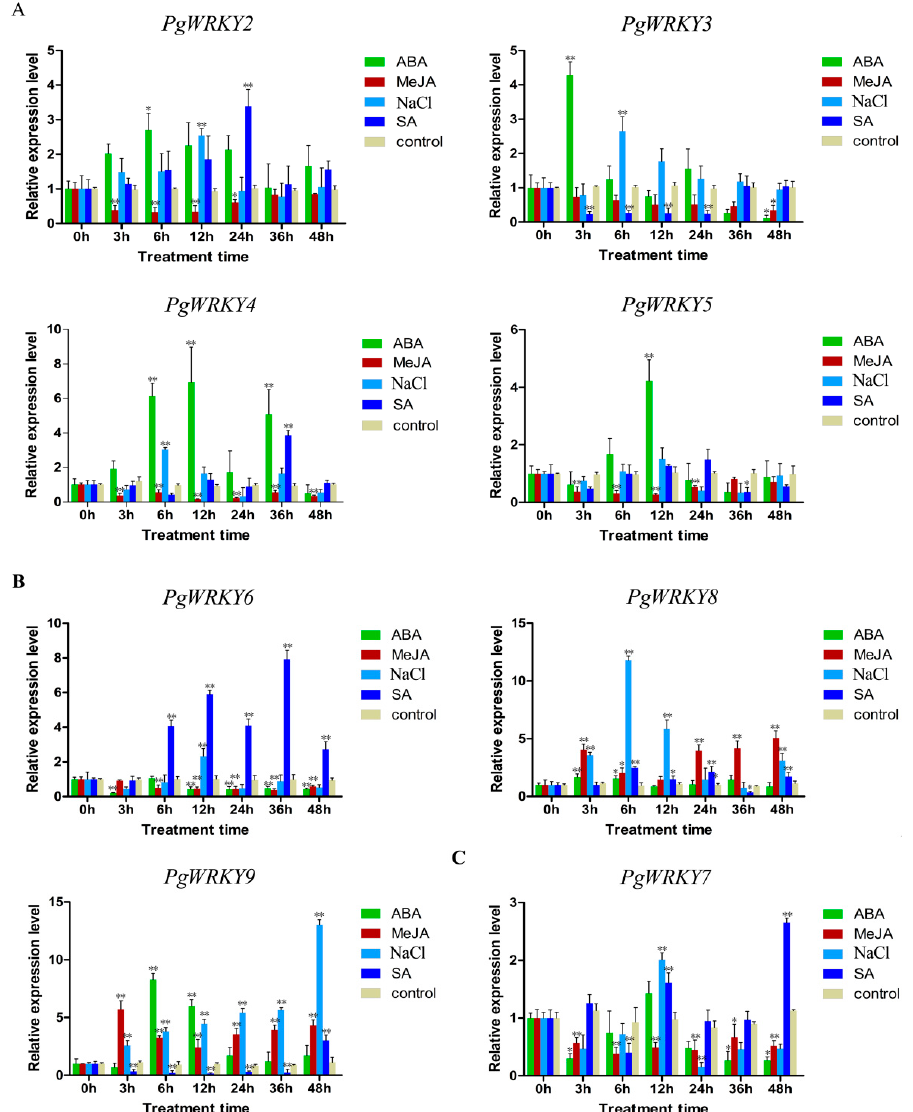
Figure 5. Expression profiles of the eight analyzed PgWRKYs ( PgWRKY2-9 ) in P. ginseng hairy roots treated with 200 µM MeJA, 200 µM SA, 20 µM ABA, and 50 mM NaCl. ( A ) Subgroup II-d; ( B ) Subgroup II-e; and ( C ) Subgroup II-c. The hairy roots treated with equal amount of solvent of the corresponding chemicals were used as control (0, 3, 6, 12, 24, 36, and 48 h). The transcript levels at different time points (0, 3, 6, 12, 24, 36, and 48 h) were measured by qRT-PCR. The levels of gene expression in the treated samples were analyzed on the basis of the corresponding gene expression at 0 h using the 2 −∆∆ C t method. The error bars represent the standard deviation (SD) from triplicate experiments. The differences between the level of transcript of treated and control hairy roots at 0 h are statistically significant ( * p < 0.05) and extremely significant ( ** p < 0.01) according to independent samples t -test.